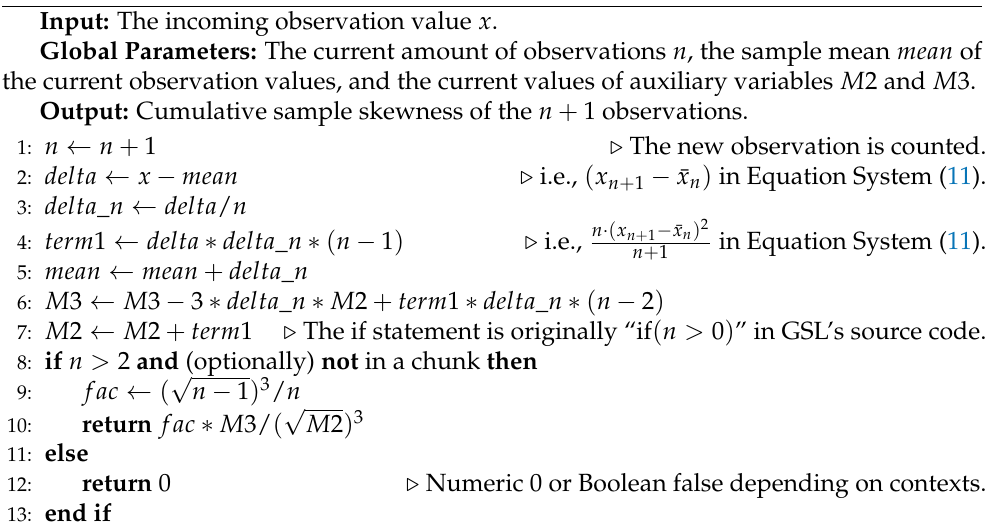
Algorithm 1 Cumulative Sample Skewness in